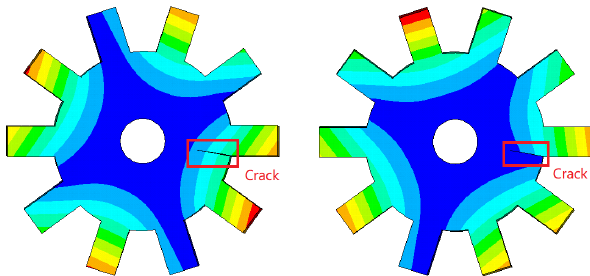
Figure 5. The 2ND mode shapes of a disk with a 56mm